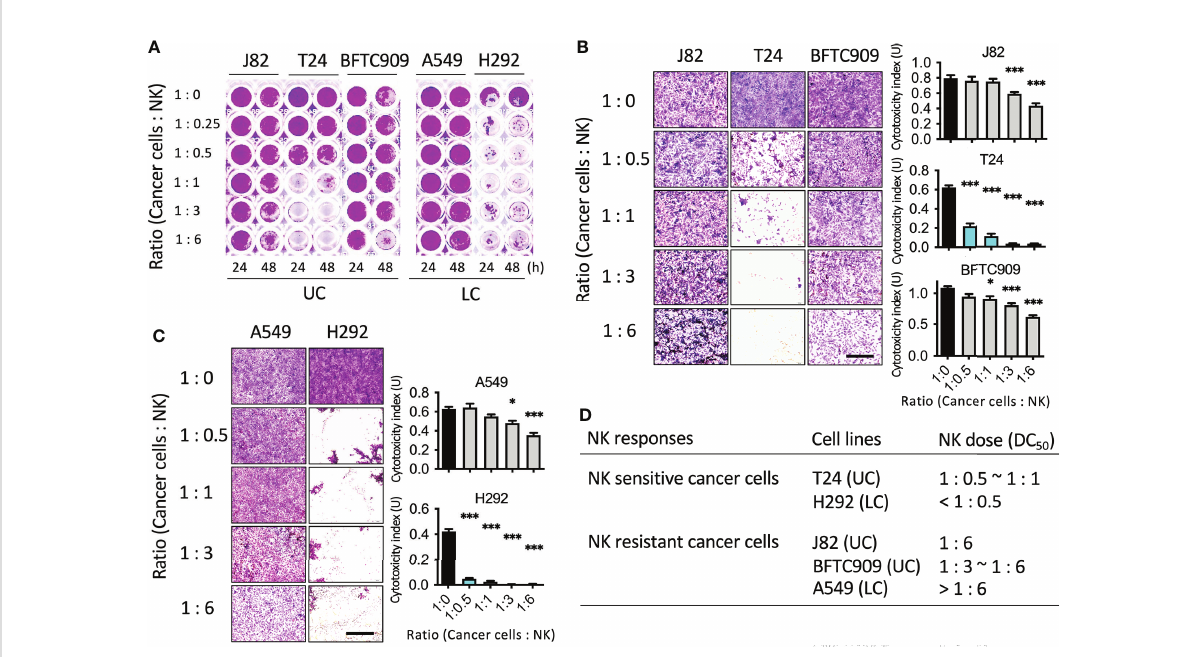
FIGURE 1 Identi fi cation of the cancer cell lines susceptible or resistant to NK cell-mediated cell death. (A) NK cytotoxicity assay using cancer cells from urothelial cancer (UC) and lung cancer (LC). Cells were seeded in the 96-well plate and incubated with NK cells for 24 or 48 h. (B) J82, T24 and BFTC909 cells were co-cultured with NK cells for 48 h and stained with crystal violet. The stained cells were observed by microscope. (C) A549 and H292 cells were co-cultured with NK cells for 48 h and stained with crystal violet. The stained cells were observed by microscope. (D) The NK sensitive or resistant cancer cells and the dose of NK ratio are listed. Scale bars, 1 mm. * P < 0.05; *** P < 0.001. Data are presented as mean ± s.d. (one-way ANOVA with Dunnett ’ s multiple comparisons test) and experiments were repeated three times (n =